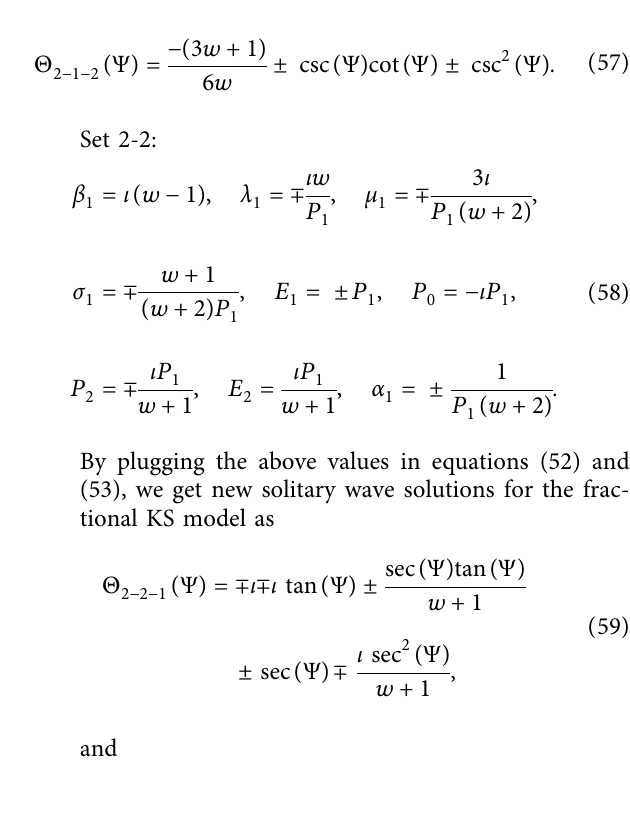
� 0 . 5, and w � 0 . 3. (a) Θ 131 , (b) Θ 132 , (c) Θ 131 , Θ 132 1